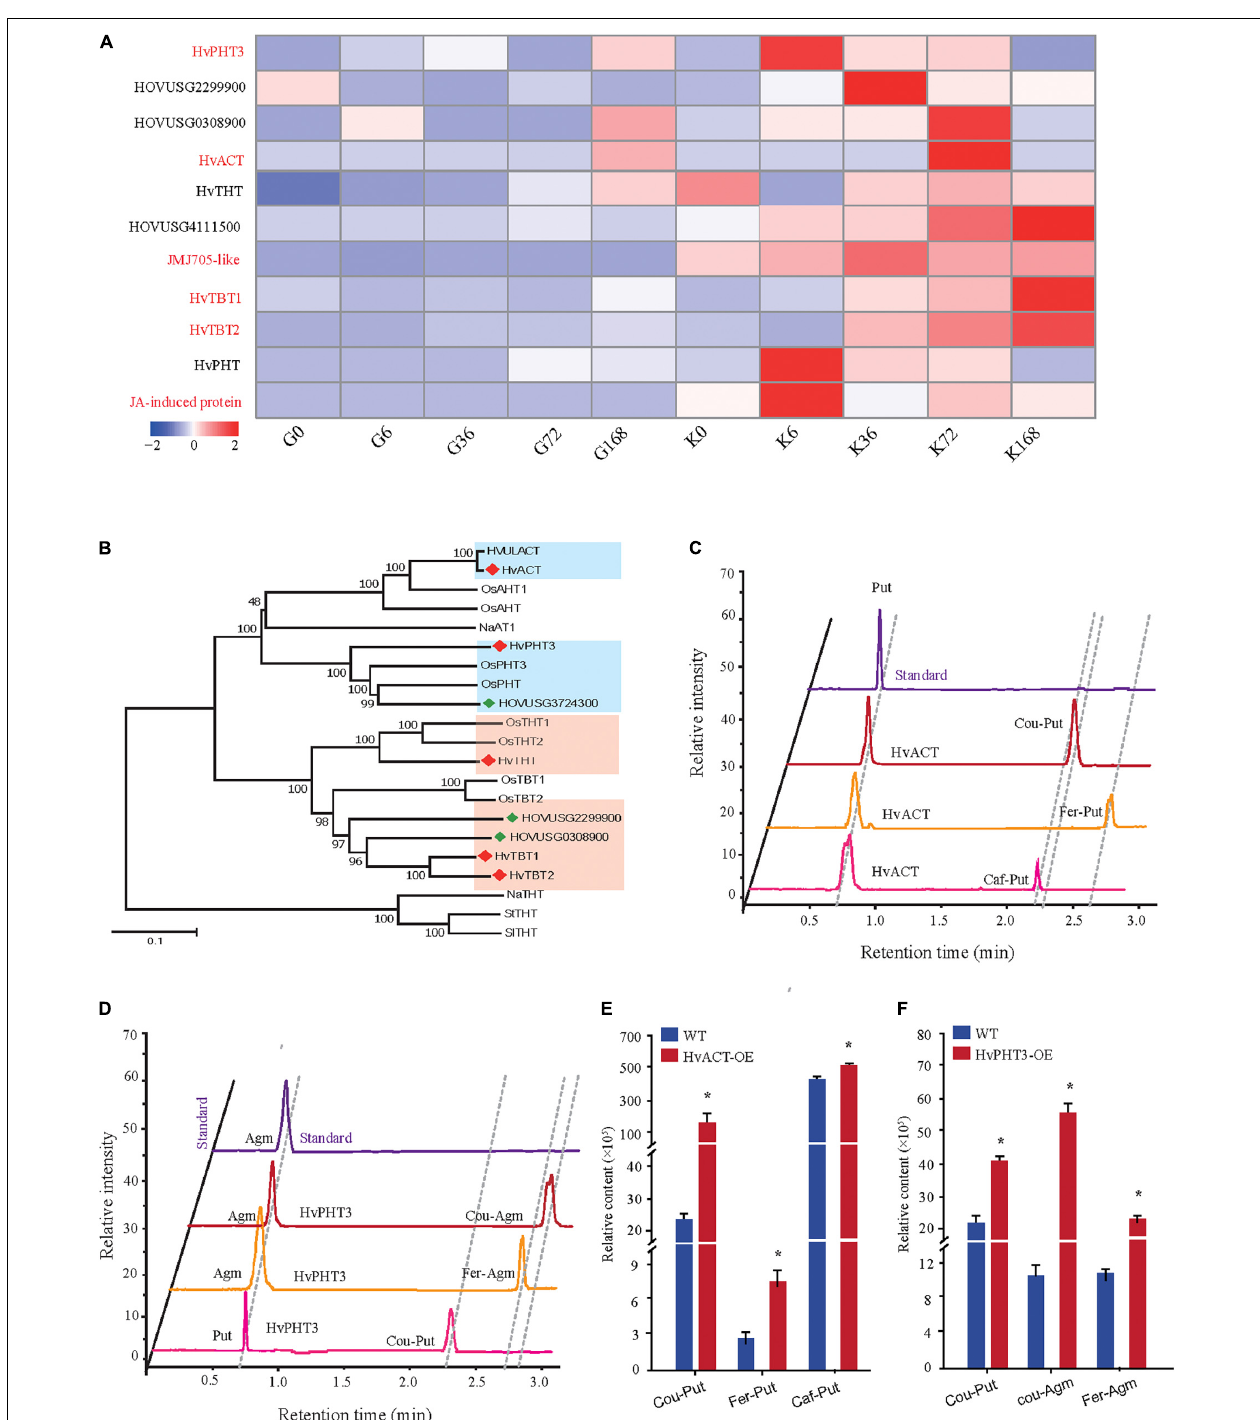
FIGURE 5 | Functional characterization of HvPHT3 and HvACT . (A) Expression pattern of PAs biosynthesis-related N -acyltransferases, JMJ705 and JA-induced protein in K69 and G72 lines during powdery mildew treatment. (B) The phylogenetic tree was built. BAHD proteins and five candidate genes sequences in phylogenetic tree were shown in Supplementary Table 2 . (C) Validation of HvACT function by in vitro enzymatic activity. (D) Validation of HvPHT3 function by in vitro enzymatic activity. (E) Bar plots for the content of Cou-Put (coumaroyl putrescine), Fer-Put (feruloyl putrescine) and Caf-Put (caffeoyl putrescine) in HvACT overexpressing tobacco and wild-type tobacco. (F) Bar plots for the content of Cou-Put (coumaroyl putrescine), Cou-Agm (Coumaroyl agmatine) and Fer-Agm (feruloyl agmatine) in HvPHT3 overexpressing tobacco and wild-type tobacco. Data indicate mean value ± standard deviation (SD) with three replicates. * Indicates significant difference ( P < 0.05, according to t -test). HvPHT3 : HOUSG2299900 ; HvACT : HOVUSG5340700 ; HvTHT: HOVUSG1220400 ; JMJ705 - like : HOVUSG0811000 ; HvTBT1 : HOVUSG0308500; HvTBT2 : HOVUSG0309600 ; HvPHT : HOVUSG3724300 ; JA-induced protein : HOVUSG1730700 .